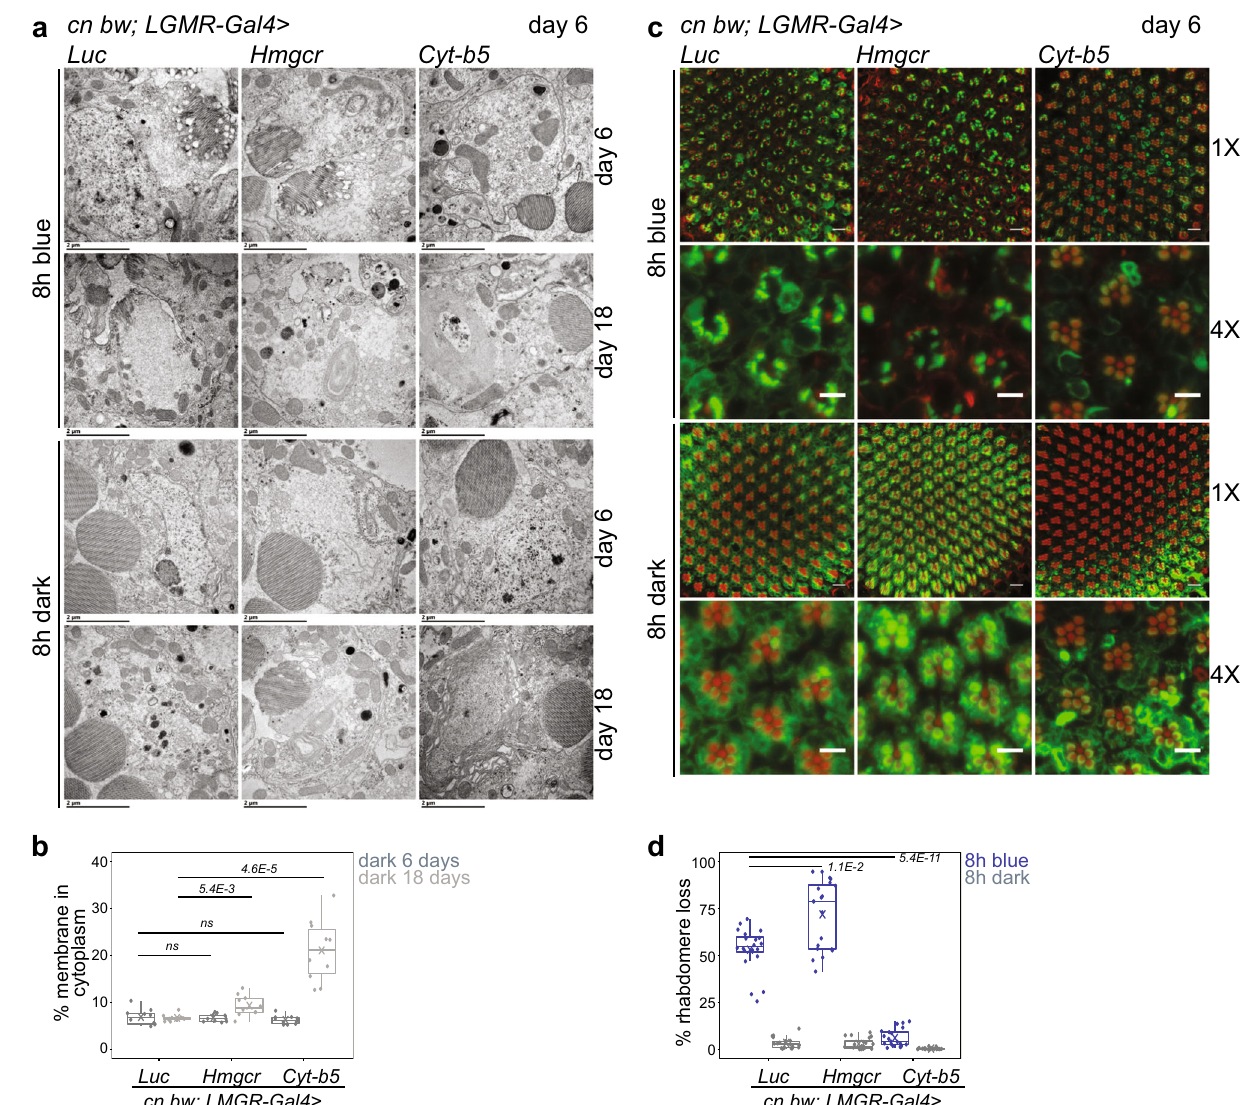
Fig. 4 Overexpression of Cyt-b5 suppresses blue light-induced retinal degeneration. a Transmission electron microscopy of cross sections of ommatidia from adult male fl ies expressing single copy transgenes for Luciferase (Luc) , Hmgcr, or Cyt-b5 driven by LGMR-Gal4 . All mini-white marked transgenes were crossed to cn bw to deplete eye pigments. Flies were exposed to blue light exposure or dark control at 6 days post- eclosion and retinas were either dissected immediately (day 6) or after a further 12 days of dark incubation (day 18). Sections containing nuclei for a single R1 – R6 cell are shown. Scale bars: 2 μ m. b The percentage of cytoplasm containing intracellular membranes was quanti fi ed for dark treated animals at 6 days or 18 days post-eclosion using the electron microscopy images. FDR, pairwise Wilcoxon Rank Sum Test between Luciferase and Hmgcr or Cyt-b5 for the same age ( n = 3 animals; 3 – 4 ommatidia/animal). c Confocal images of adult retinas from male fl ies of the indicated genotypes exposed to 8 h blue light or dark control. d Box plots showing rhabdomere loss quanti fi ed using the confocal images. FDR, pairwise Wilcoxon Rank Sum Test between Luciferase and Hmgcr or Cyt-b5 under blue light treatment ( n = 4 light treatments; 5 animals/ experiment). ns not signi fi